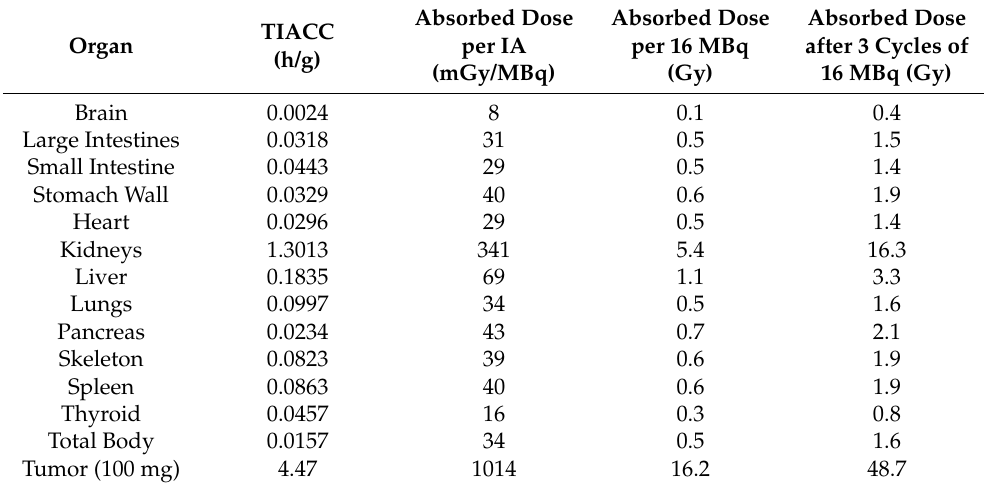
Figure 8. Time-activity concentration curves for ( A ) kidneys and ( B ) SKOV-3 tumor. The biodistri- bution data were fitted with bi-exponential curves; in the kidneys 90%/g with T 1/2 = 44 min and 3%/g with T 1/2 = 17 h and in the tumor uptake proceeded with T 1/2 = 35 min to a maximum of 49%/g and clearance with T 1/2 = 12 h. The fitted curves and its 95% confidence intervals are indicated. The absorbed dose values are indicated in Table 3. The kidneys receive the highest dose of the organs with physiological uptake at 341 mGy/MBq. The absorbed dose to the tumor is a factor 3 higher. The dose to the skeleton and bone marrow of 39 mGy/MBq might limit the total amount of activity that can be injected. In humans the maximum tolerated absorbed dose to the bone marrow is 2 Gy. Table 3. Dosimetry results for 188 Re-ZHER2:41071 in NMRI mice with Time Integrated Activity Con- centration Coefficients, the absorbed per injected activity, per 16 MBq therapy cycle and cumulative absorbed dose after 3 × 16 MBq.